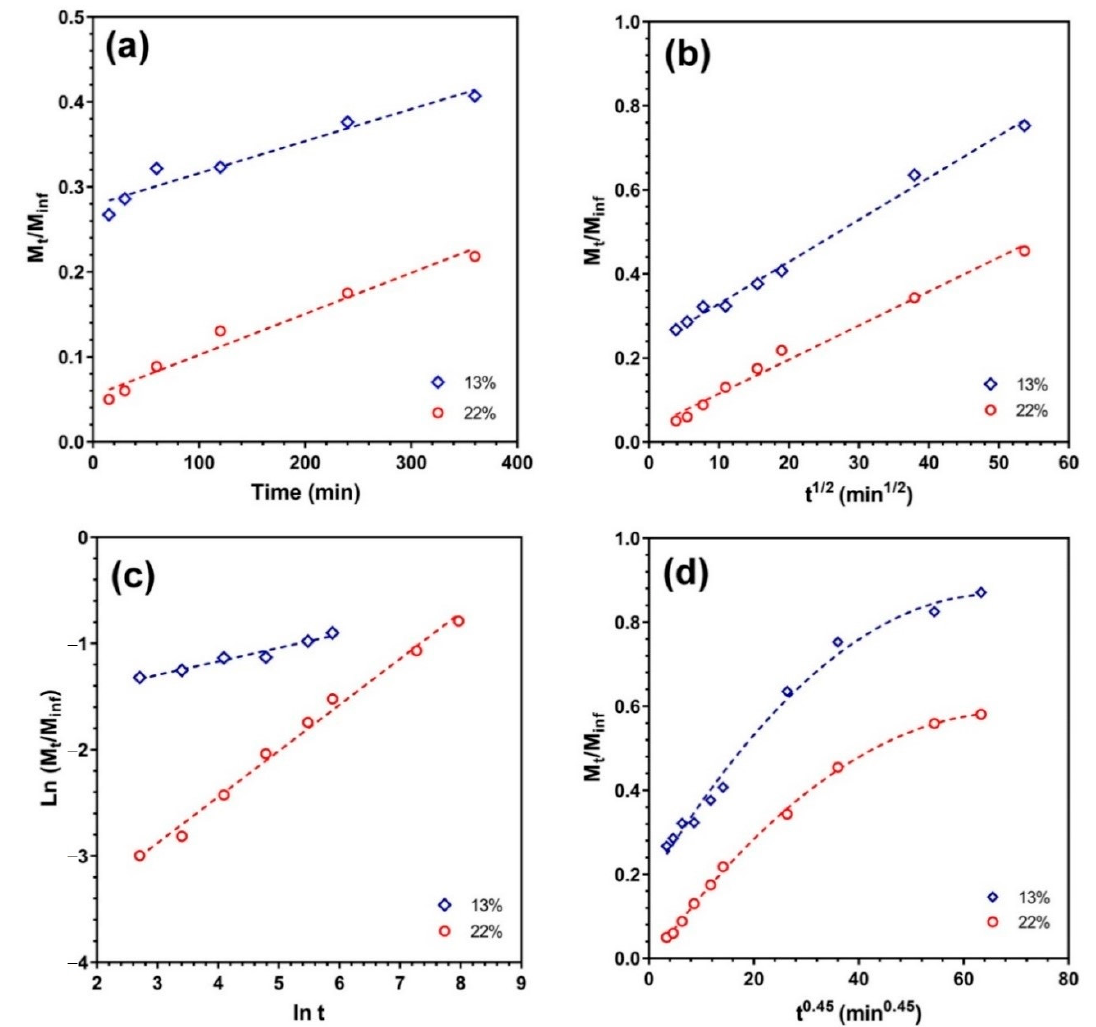
Figure 8. Release dynamics of AM from loaded Plx- g -CMP hydrogels in PB (pH 7.4) at 37 °C: plots of zero-order ( a ), Higuchi ( b ), Ritger–Peppas ( c ) and Peppas–Sahlin ( d ) models. Table 1. Release parameters corresponding to AM-loaded Plx- g -CMP hydrogels of 13% and 22% copolymer concentration. Conc. (%, w / v